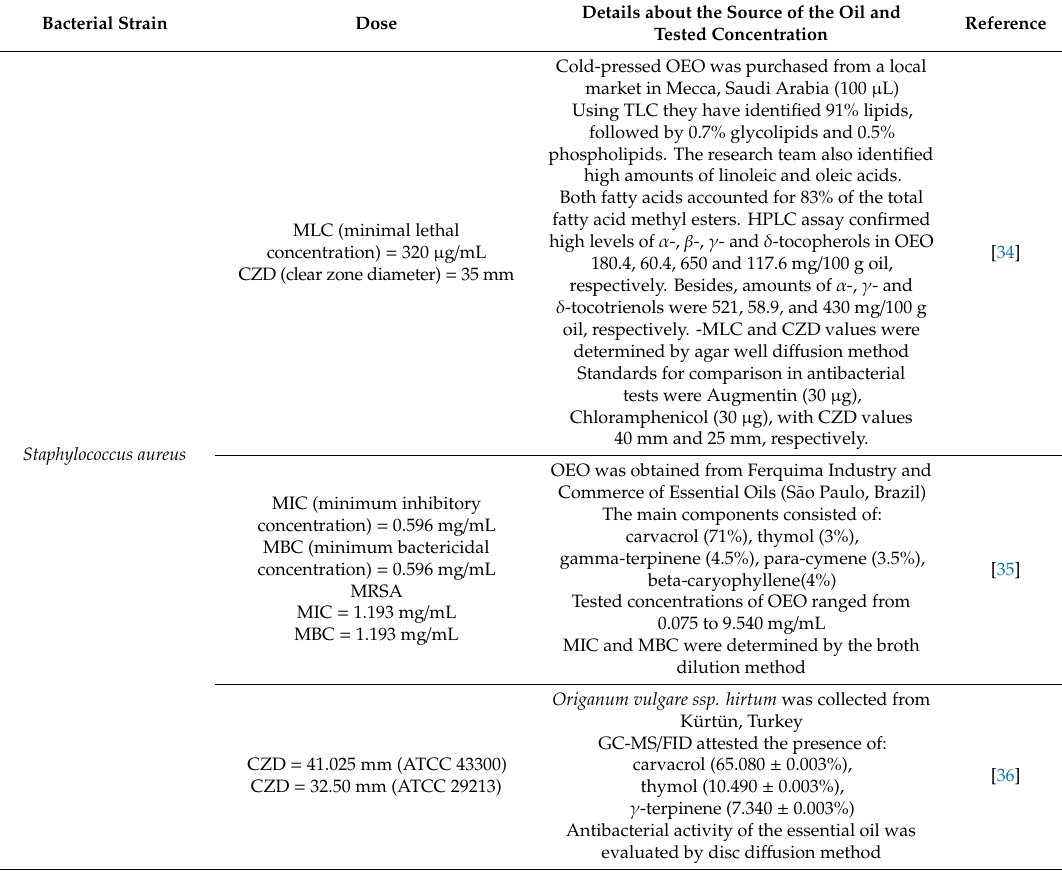
Table 1. Antibacterial activity against Gram-positive